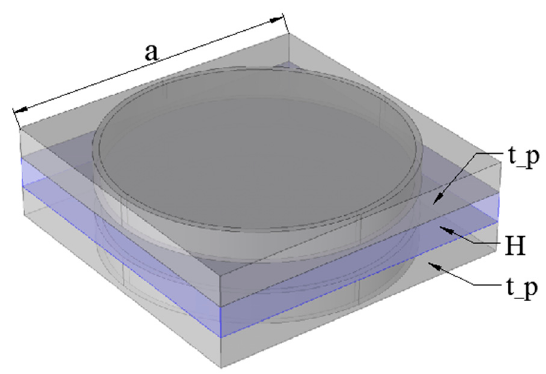
Table 1. Material parameters.